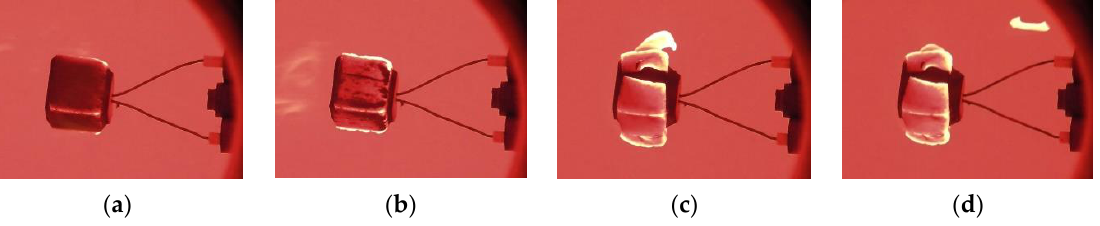
Figure 6. Particle fragmentation and preceding stages. Time elapsed after sample placing into the furnace is given under the photos. On the right of the photos a part of a type A holder is seen. ( a ) 4.3 s, ( b ) 4.5 s, ( c ) 5.0 s, ( d ) 5.4 s.